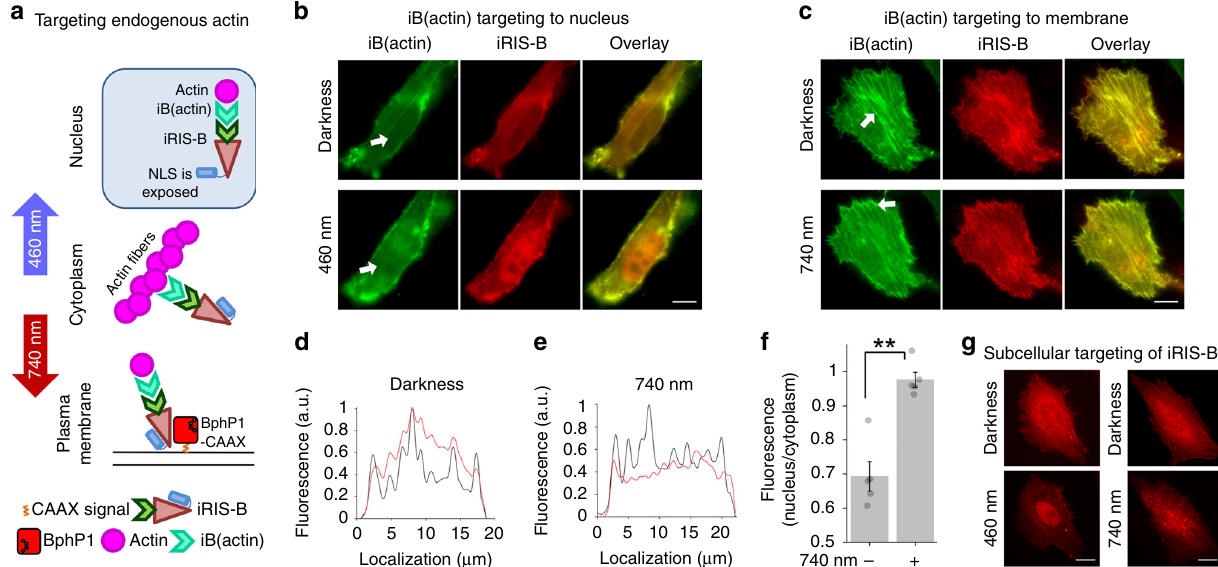
Fig. 3 Spectral multiplexing allows targeting of both cytoplasmic and nuclear actin. a Schematic representation of dual-wavelength light-controlled perturbation of endogenous non-tagged actin by iB(actin) – iRIS-B system. b Optical control of iB(actin) localization in cells transfected with iRIS-B. In darkness, intrabody highlights cortical actin, stress fi bers, and is excluded from the nucleus. Under blue light, iB(actin) concentration is increased in nucleus. Epi fl uorescence microscopy; scale bar, 10 μ m. c In cells analogous to those shown in b , under NIR light, iB(actin) disengages from stress fi bers and cytoplasmic structures and binds plasma membrane due to interaction with BphP1-CAAX. Epi fl uorescence microscopy; scale bar, 10 μ m. Intensity pro fi les of fl uorescence signals in cell expressing iB(actin), black line, and iRIS-B, red line, before ( d ) and after ( e ) 740 nm illumination. Respective epi fl uorescence microscopy image is provided in Supplementary Fig. 6b. Source data are provided as a Source Data fi le. f iB(actin) accumulation in nucleus under 460 nm illumination. Ratios averaged from fi ve regions of interest from image shown in Supplementary Fig. 6a. Error bars represent SEM, ** p < 0.01 (two tailed, Student ’ s t test). Source data are provided as a Source Data fi le. g Cells transfected with iRIS-Ba construct in which the system for tridirectional protein targeting (iRIS) is fused to iB(actin) directly. Under blue light, iRIS-Ba concentration is increased in the nucleus; under NIR light, iRIS-Ba is observed at plasma membrane due to its interaction with BphP1-CAAX, similar to iRIS-B. Epi fl uorescence microscopy; scale bar, 10 μ We illuminated serum-starved U2OS cells co-expressing the examined subcellular localization of myocardin-related tran- iRIS-B and iB(actin) with 460 nm light to enrich actin in nucleus, scription factor A (MRTF-A), which is a transcription cofactor of as in (Figs. 3b, f and 4a). The cells were then stimulated with serum response factor. Binding of monomeric actin to the RPEL- serum, fi xed, and MRTF-A subcellular localization was examined domain of MRTF-A regulates nucleocytoplasmic shuttling of by immunostaining. In the serum-starved conditions (Fig. 5a, MRTF-A by inhibiting its nuclear import and enhancing nuclear upper panel), MRTF-A was mainly cytoplasmic, as reported export 35 .